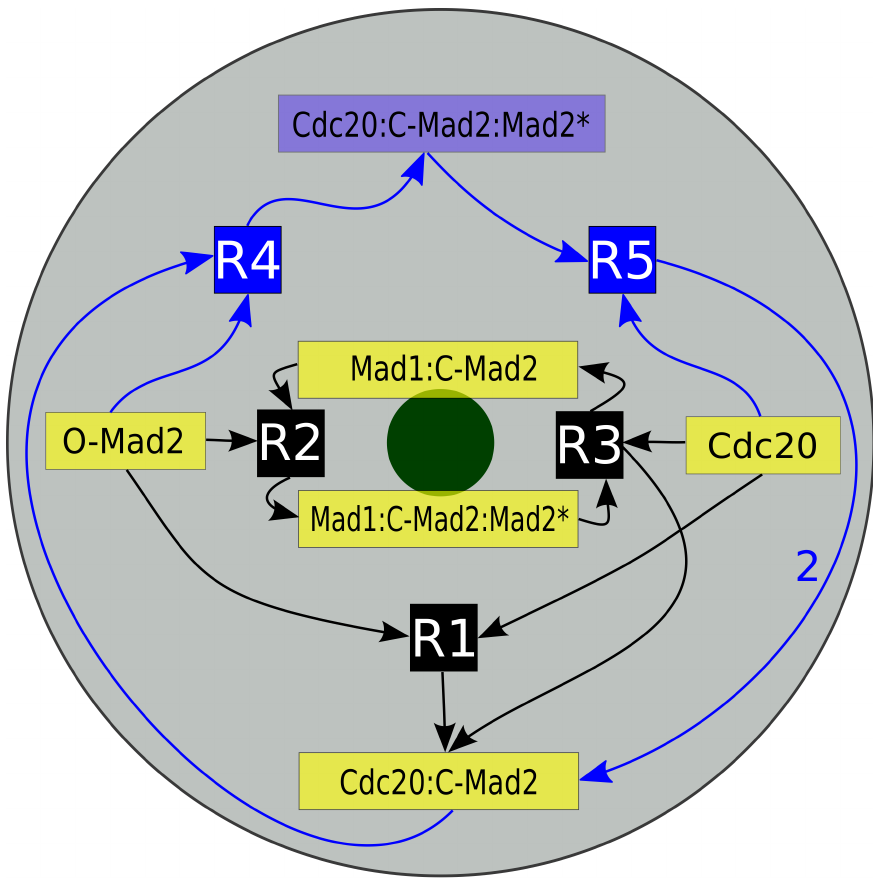
Figure 2. Schematic diagram of the “Mad2 template” model. Depicted is a projection of our mitotic cell. The gray disk corresponds to the cell while the green disk presents the last unattached kinetochore. Inscribed is the reaction network of the “Mad2 template” model with species localization. The core model consists of five species (yellow boxes) and their three reactions (black boxes R1, R2 and R3). The full model furthermore contains the amplification pathway, which is symbolized by the blue boxes (Cdc20:C-Mad2:Mad2*, R4 and R5). The arrows’ directions indicate whether a species is a reactant or a product. Mad1:C-Mad2 and Mad1:C-Mad2:Mad2* are localized predominantly in the vicinity of the kinetochore and the later catalyzes reactions R2 and R3. The autocatalytic amplification reactions of Cdc20:C-Mad2 occur in the cytosol (see Section 2 for